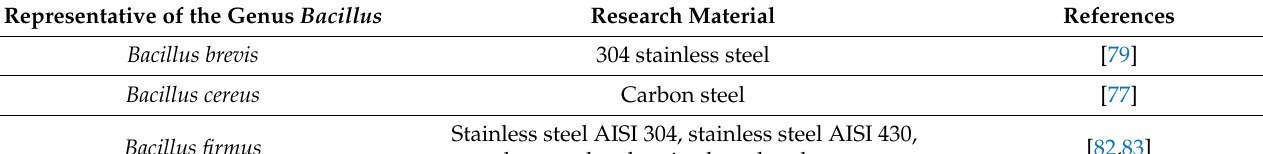
Table 6. Protective activity of bacteria of the genus Bacillus in relation to material biodegradation. Representative of the Genus